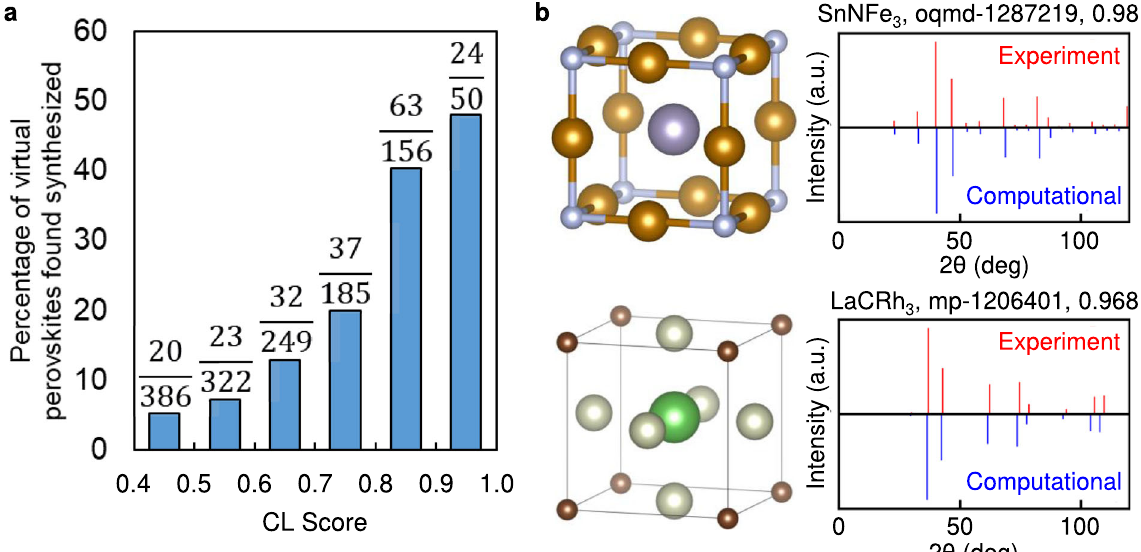
Fig. 3 Model validation. a The percentage of virtual perovskites that are found synthesized in the literature. The ratio indicates the number of found over the number of virtual crystals in the range. b The structure of virtual crystals and XRD comparison between the experimental and virtual crystals for the top two perovskites previously reported in refs. 71,72 . The full list of virtual crystals and XRD pattern comparison are shown in Supplementary Table 3 and Supplementary Fig.